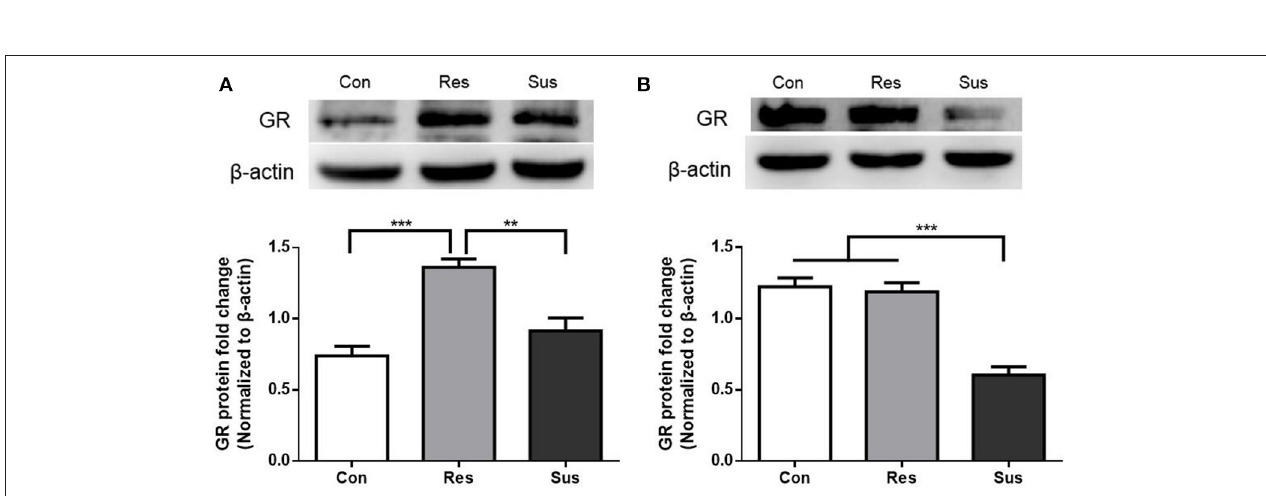
FIGURE 3 | GR protein expression were differently regulated in resilient and susceptible mice. (A) GR protein expression in the hippocampus of mice after exposure to social defeat stress ( n = 7/group). (B) GR protein expression in the hypothalamus of mice after exposure to social defeat stress ( n = 7/group). All data are shown as mean ± s.e.m. ** P < 0.01, *** P < 0.001. Con, Control; Res, Resilient; Sus, Susceptible.